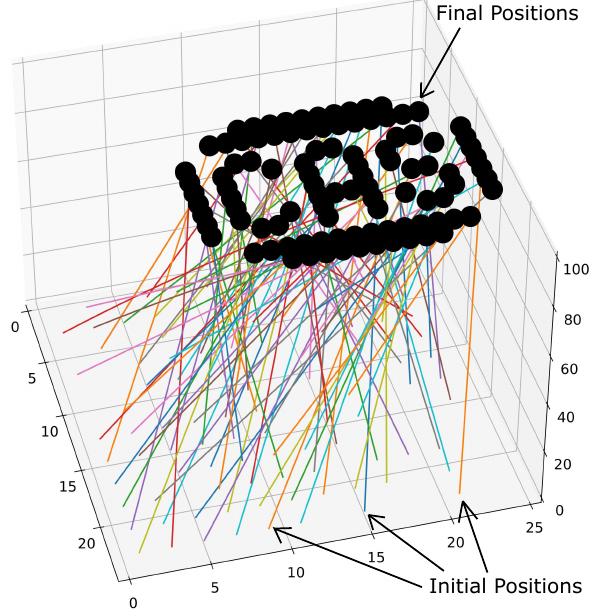
Figure 35. 101 vehicles spelling out CAS using the centralized